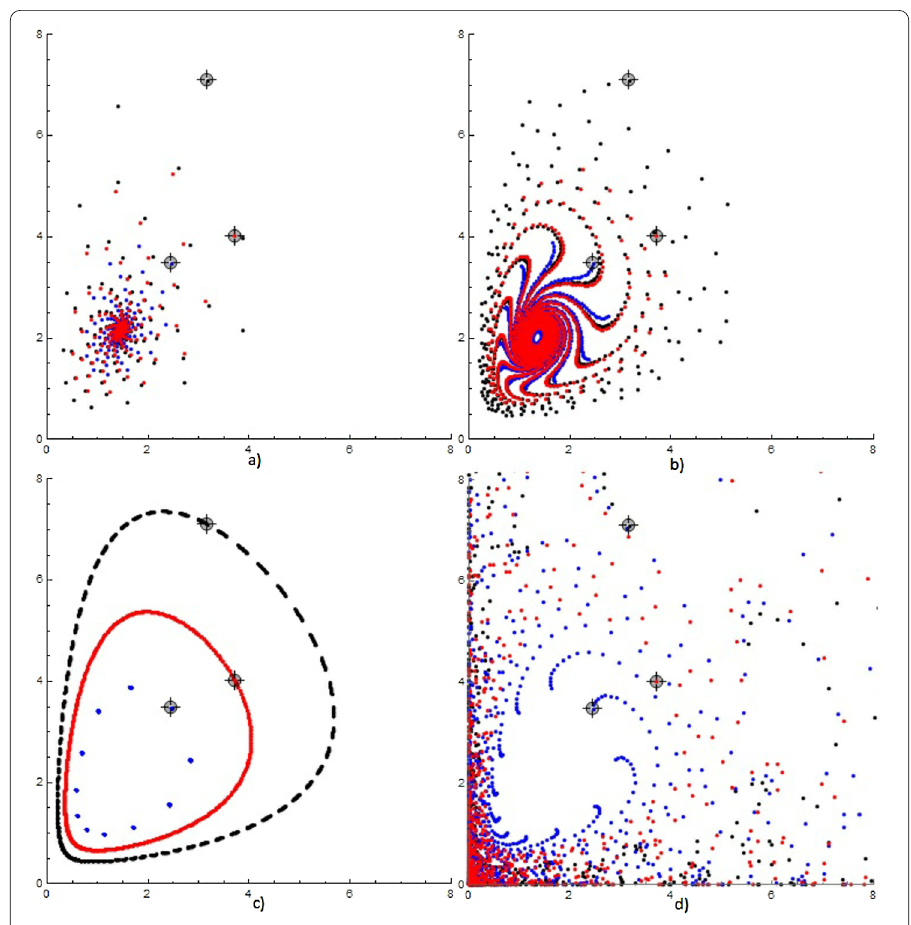
Figure 1 Trajectories for a = 3.0, b = 1.12, c = 0.5. ( a ) m = 0.9, ( b ) m = 99, ( c ) m = 1.0, and ( d ) m = 1.01 for model